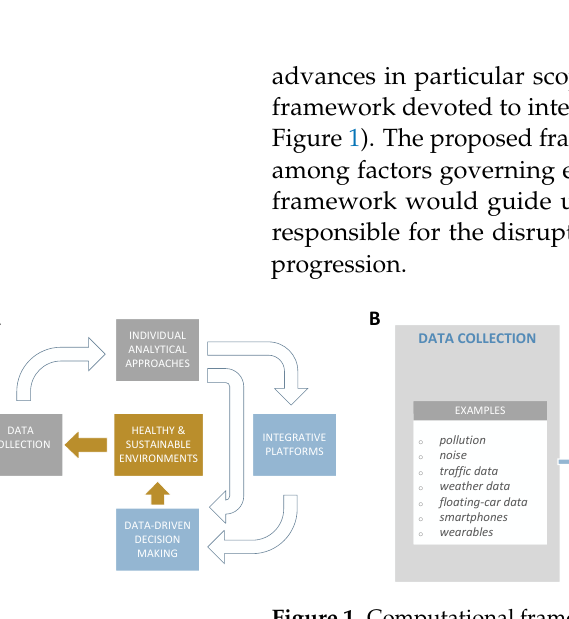
Figure 1. Computational framework for integrative analyses of rhythmic data. ( A ) The establishment of the proposed computational framework shall enable data-driven decision making guided beyond a single domain. ( B ) The application of the proposed computational framework would allow the implementation of comprehensive data-driven decision making in fostering sustainable and healthy urban